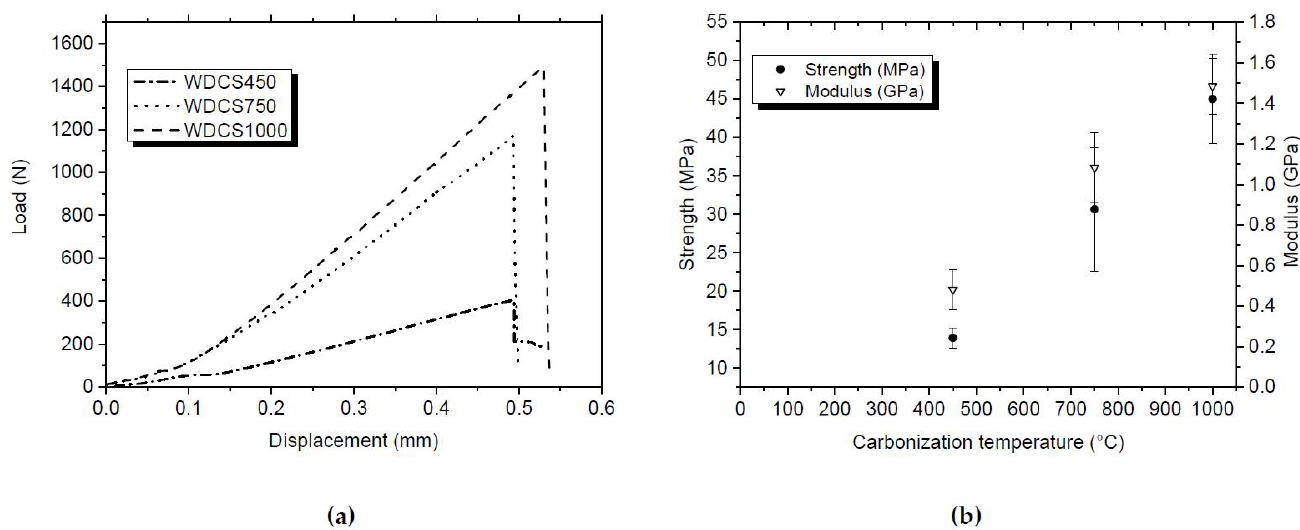
Figure 3. ( a ) Selected examples of the compressive tests carried out with WDCSs; ( b ) compressive strength and modulus of the WDCSs prepared at different carbonization temperatures.